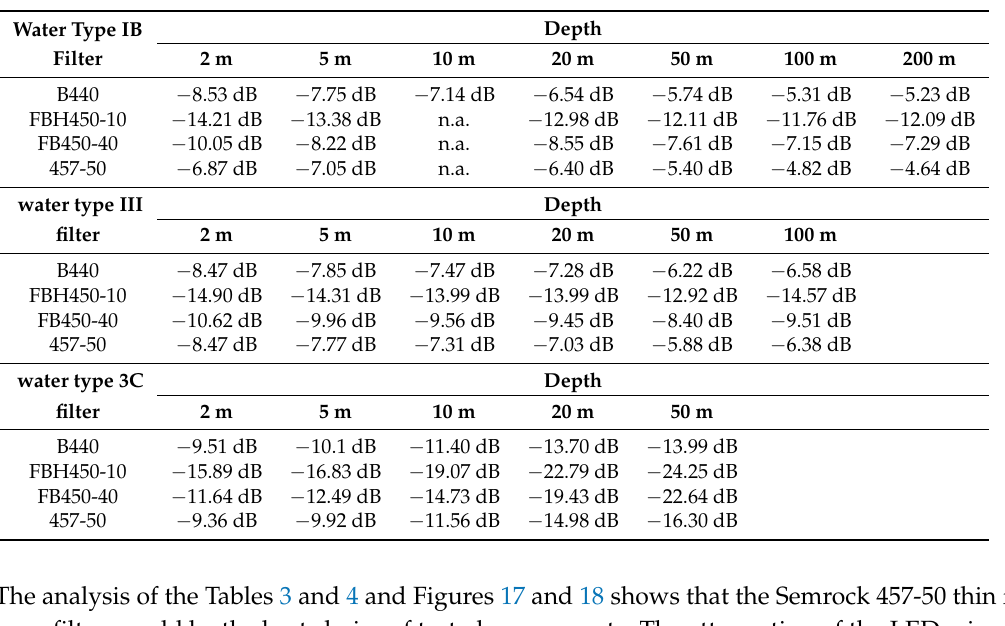
Table 4. Calculated ambient light suppression for the four different filters in three exemplary water types at varying depths, up to meaningful remaining light values. Generally calculated with filter characteristics for diffuse light, with the exception for very shallow water of 2 to 5 m in the clear water type IB. Here the characteristics of the dominating directed light were used for thin film filter (AOI = 15 ◦ ); please refer to Figure 3. Values for the thin film filters in water type IB at a depth of 10 m were not calculated, since the filter characteristic either for diffuse or directed light were applicable.